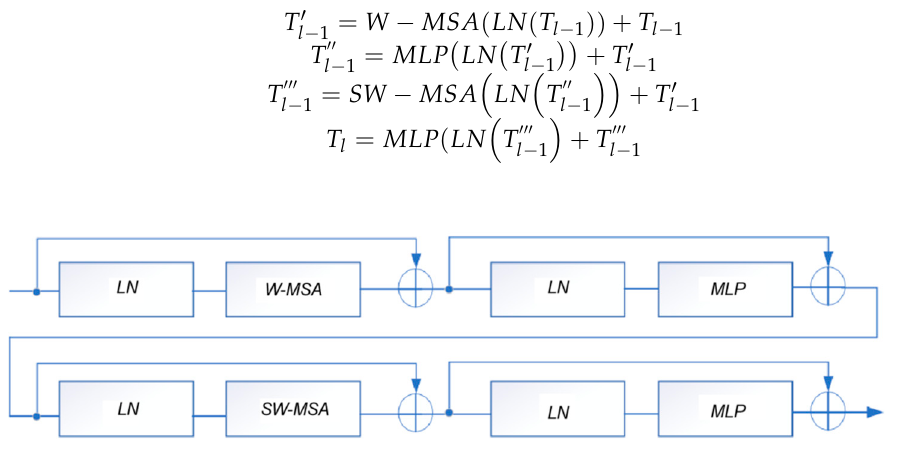
Figure 7. Structure of the block of transformer branch.